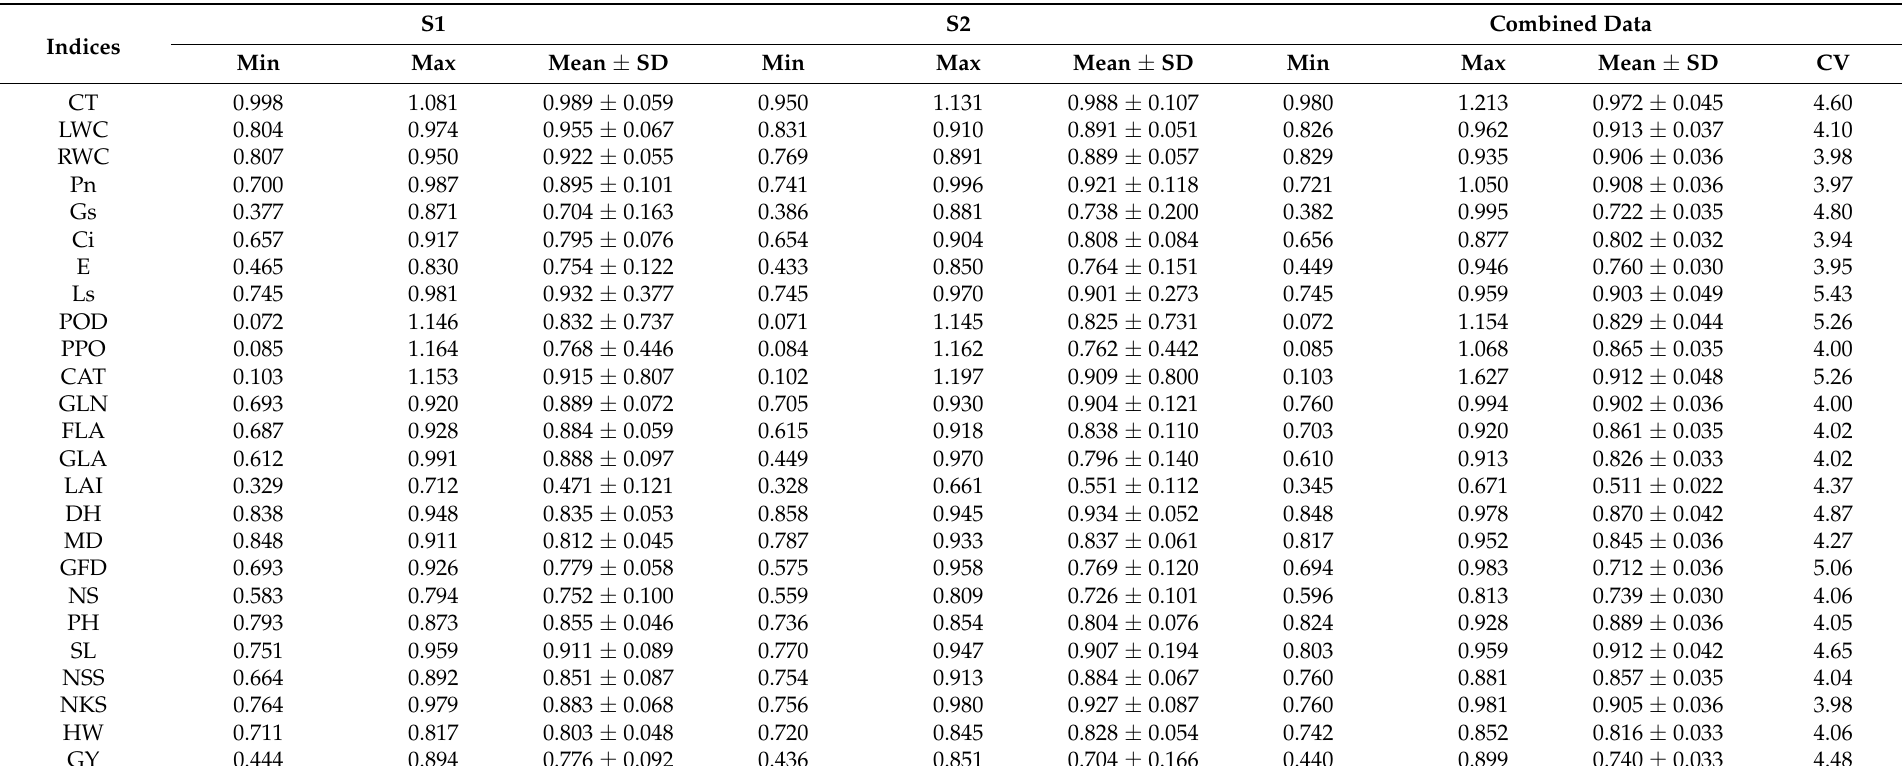
Table 2. Means ± standard deviation, ranges of the 20 genotypes of two seasons and their combined for 25